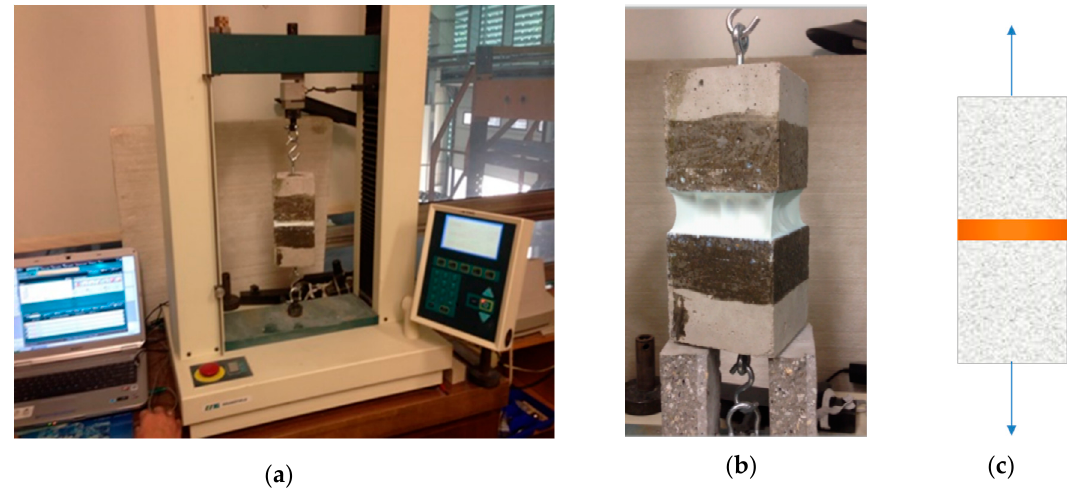
Figure 5. A view of the test stand: ( a ) testing machine, ( b ) close-up of a specimen during testing and ( c ) the adopted tension method.